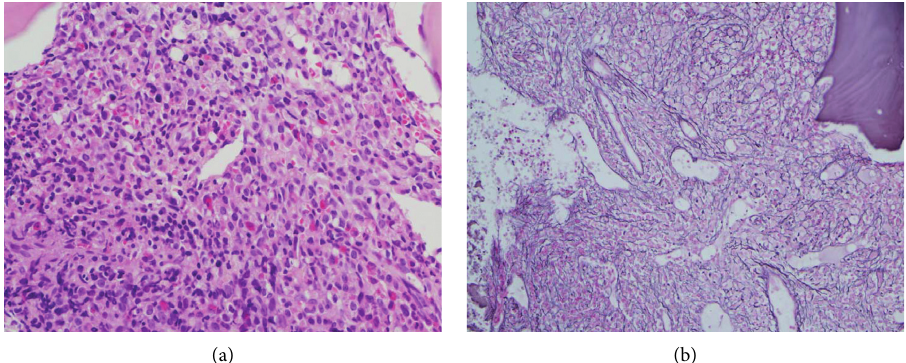
Figure 1: Bone marrow biopsy showing a hypercellular marrow with marked myeloid hyperplasia with left shift ((a) hematoxylin and eosin stain, 400x) and grade 3 fibrosis ((b) reticulin stain, 200x).